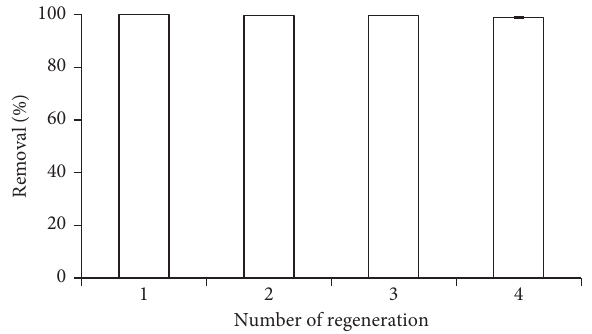
Figure 7: Removal of RhB using M 1 after four regenerations. Error bars show standard deviation of three replicates. Table 2: The removal of RhB from textile wastewater using SDS- modified nano α -Al 2 O 3